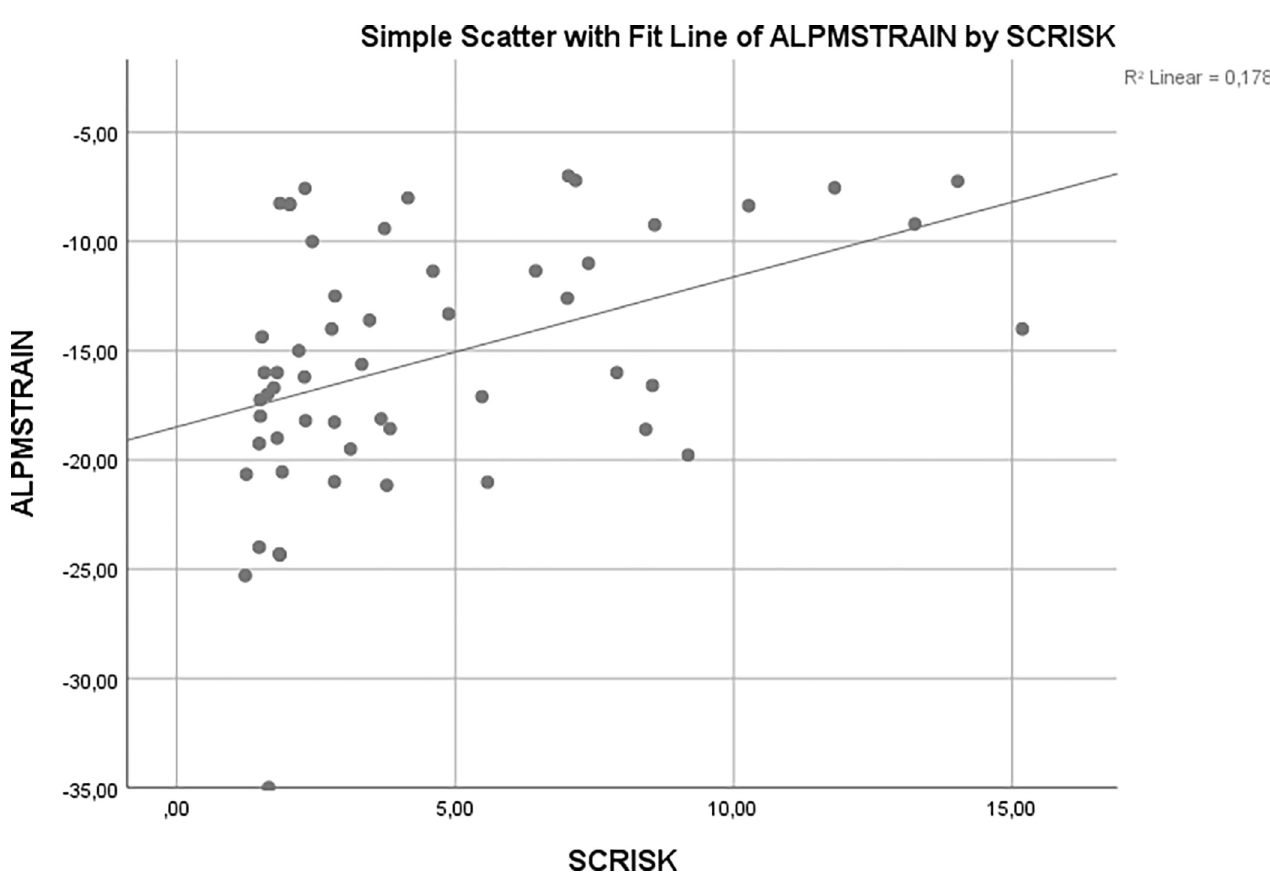
Fig 3. Correlation of ALPM free strain with SCD risk